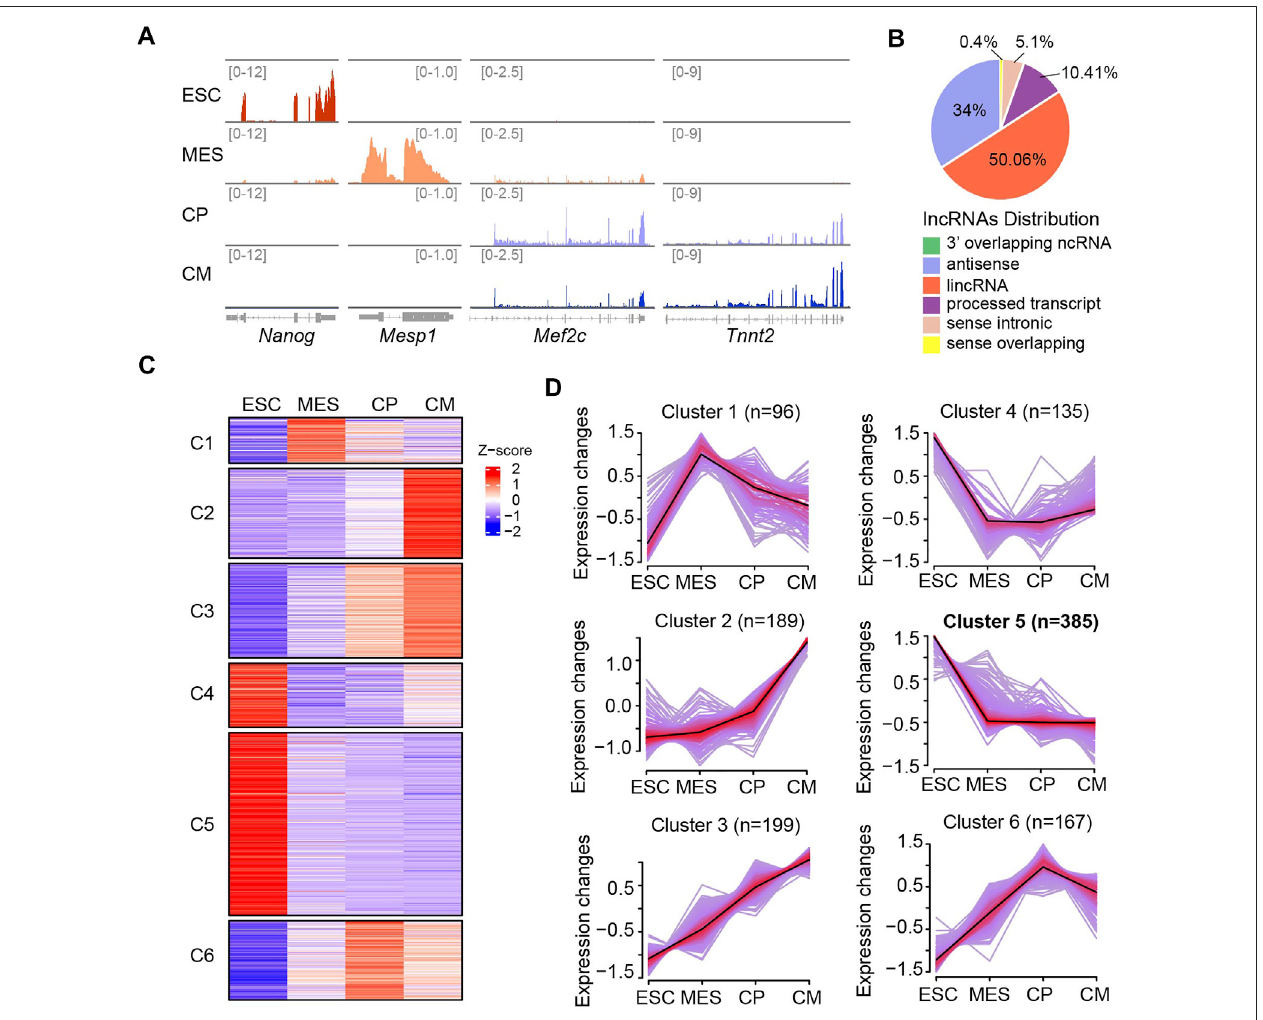
FIGURE 1 | Dynamic lncRNA expression pattern during ESC-derived cardiac differentiation. (A) Integrative Genomics Viewer (IGV) of read coverage for speci fi c marker genes at distinct differentiation phases including ESC (Day 0), MES (Day 4), CP (Day 6) and CM (Day 10). The number of reads indicate the peak heights in correspondinggenomicregions. (B) GenomicannotationoflncRNAs( n =6,061)showingthatthemajorityoflncRNAsweremappedtolincRNA(50.06%)andantisense (34%). (C) Heat map showing the expression patterns of lncRNAs were grouped into six different groups (C1-C6) across four differentiation stages. (D) Clustering analysis showing the expression patterns of lncRNAs were divided into six different groups (C1-C6) as shown in (C) . The average trend is indicated by black lines. The number of genes is indicated for each cluster. The ESC-speci fi c cluster (C5) contains the largest population of lncRNAs ( n = 385).